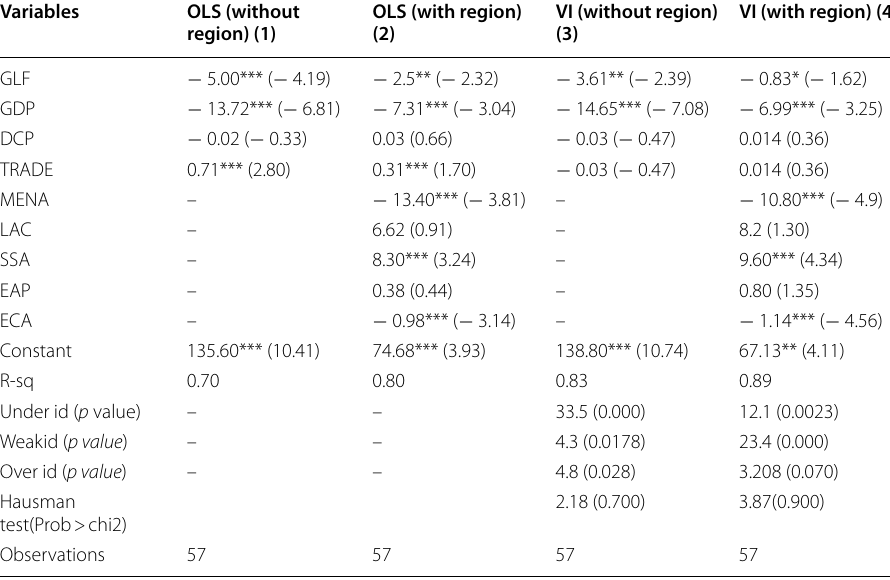
Table 2 Results based on cross-sectional